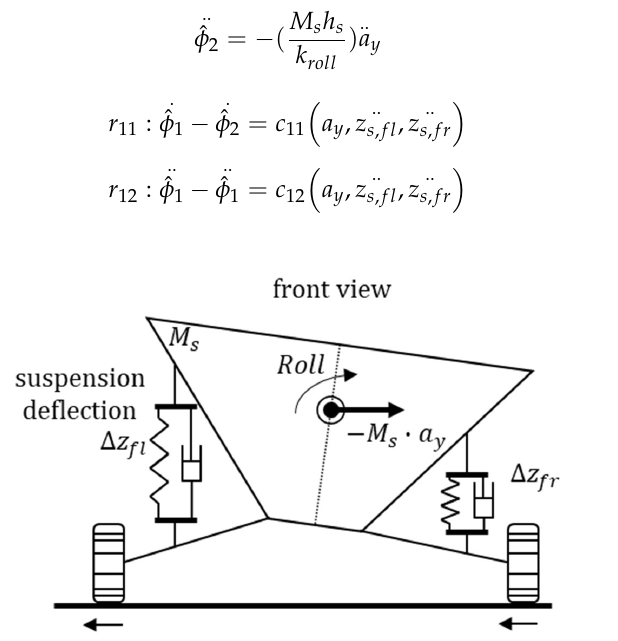
Figure 14. Vehicle roll angle scheme.